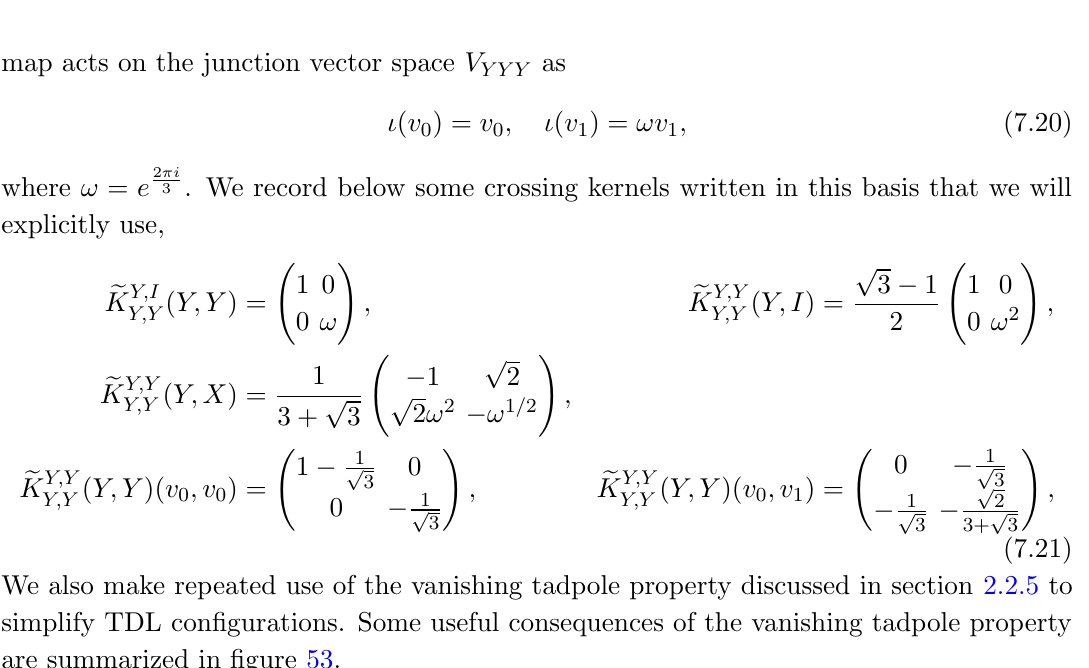
Figure 53 . Identities for removing loops deduced from the crossing relations and the vanishing tadpole